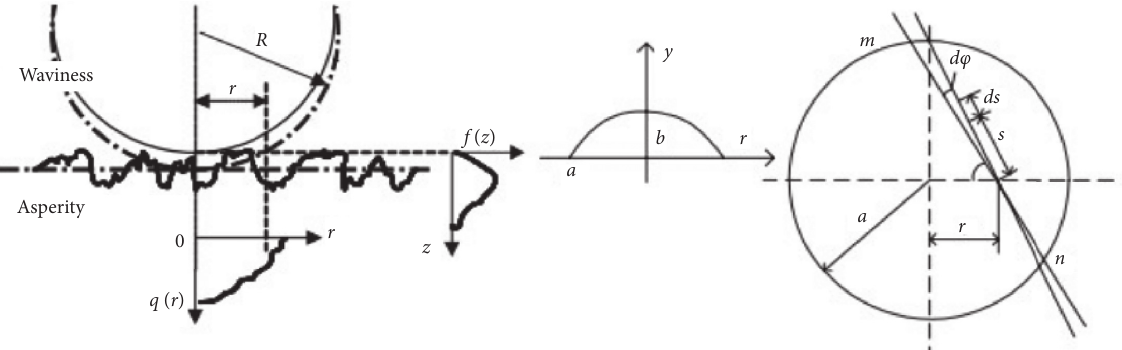
Figure 7: Contact between a “waviness” and an “unevenness.”